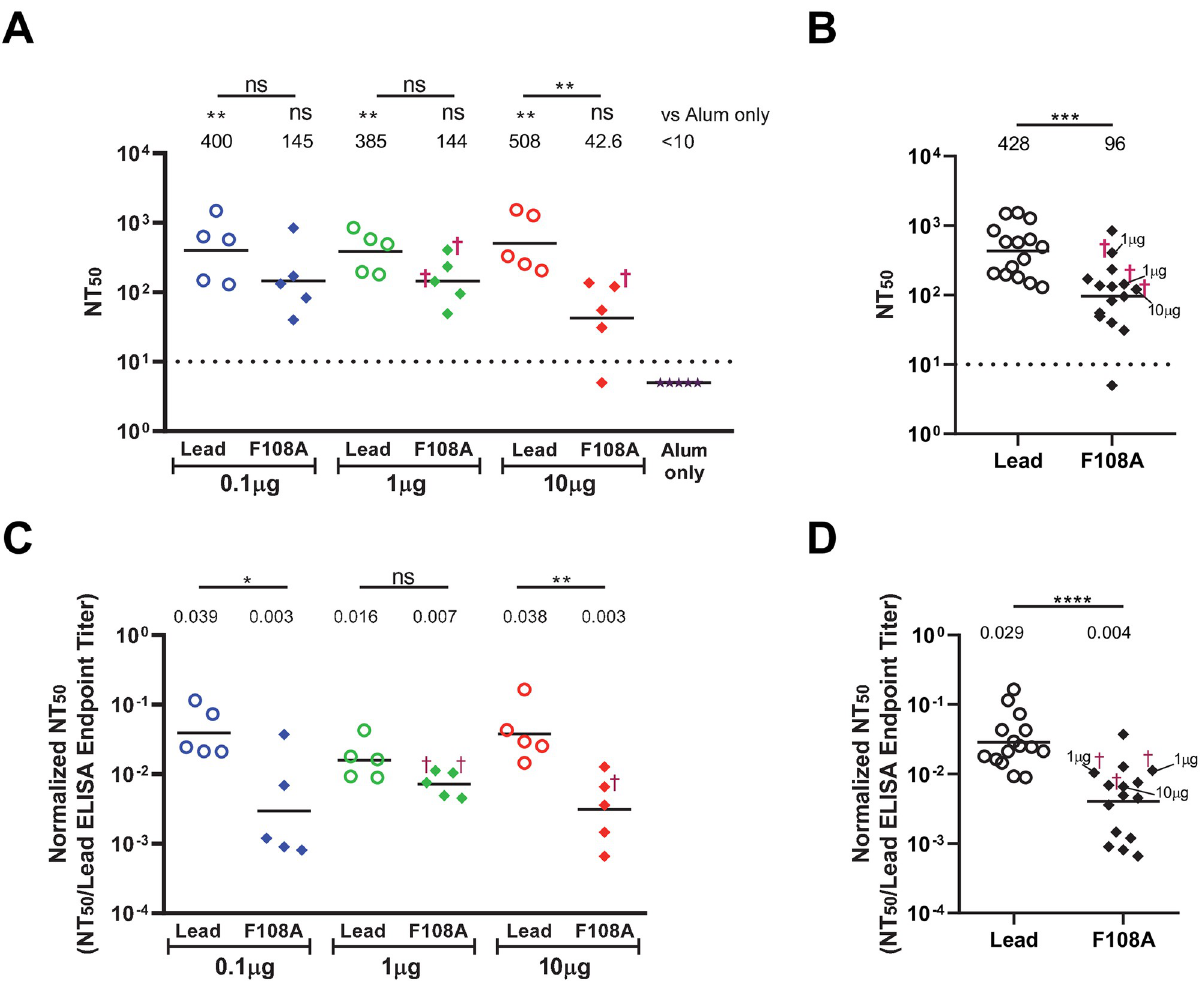
Fig 4. Lead and F108A VLP induction of nAb after booster immunization. The vaccination schedule is shown in Fig 3A. (A) NT 50 is defined as the reciprocal dilution of serum that neutralizes 50% of reporter virus luminescence calculated using linear regression analysis. Each symbol represents the NT 50 for an individual animal, and † indicates a lethal ZIKV infection. Horizontal bars represent the geometric mean titer (GMT) of each group. The dotted line is the limit of detection (LOD) of the assay, and sera with undetectable neutralization activity were assigned a value of one-half LOD (5). Statistical comparisons of NT 50 data were performed using Kruskal-Wallis test followed by Dunn’s multiple comparisons tests ( � P < 0.05; �� P < 0.01; ��� P < 0.001; ���� P < 0.0001; ns, not significant). All VLP groups were compared to the Alum-only group. Additional pairwise comparisons were performed between titers of lead and F108A groups at each dose, with significance level for each comparison shown above each bar. (B) Comparison of NT 50 titers for combined lead VLP groups compared to combined F108A VLP groups. GMT, individual NT 50 values, assay LOD, † designation, and significance value by Mann-Whitney U test are as in (A). (C) Ab quality assessment by the ratio of NT 50 to ELISA titer to lead VLP are shown for each dose of lead or F108A VLP. Group geometric mean titer ratios are shown above each group, individual ratios are shown by a symbol, group means by a horizontal bar, lethal infections by the symbol †, and statistical significance by Kruskal-Wallis followed by Dunn’s multiple comparison tests for each of the three doses as in (A). (D) Ab quality assessment by NT 50 to ELISA titer to lead VLP ratios are shown for combined lead and combined F108A groups. Group GMT ratios, individual ratios, lethal infections, and statistical significance levels by Mann-Whitney U test are as in